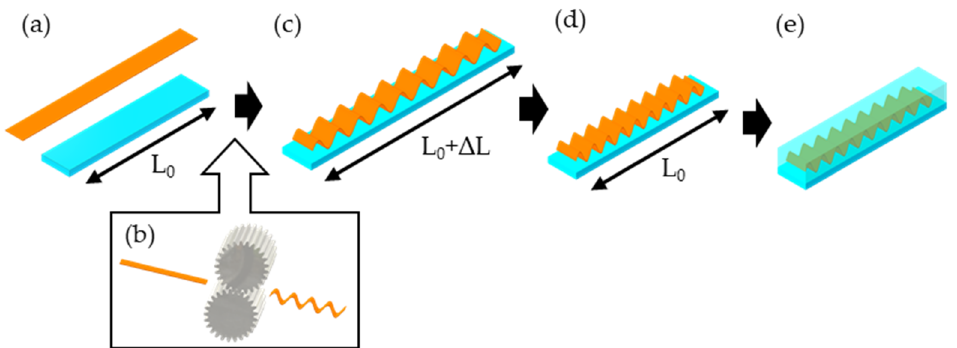
Figure 1. The proposed fabrication method of stretchable interconnects with vertical wavy structure, comprising the pre-stretch method and micro-corrugation process: ( a ) preparation of Cu foil and silicon rubber substrate; ( b ) a pair of gears continuously bending Cu foil; ( c ) micro-corrugated Cu foil is bonded and cured on the pre-stretched silicone rubber substrate; ( d ) the substrate is returned to its original length; and ( e ) the entire interconnect is embedded in silicone rubber.